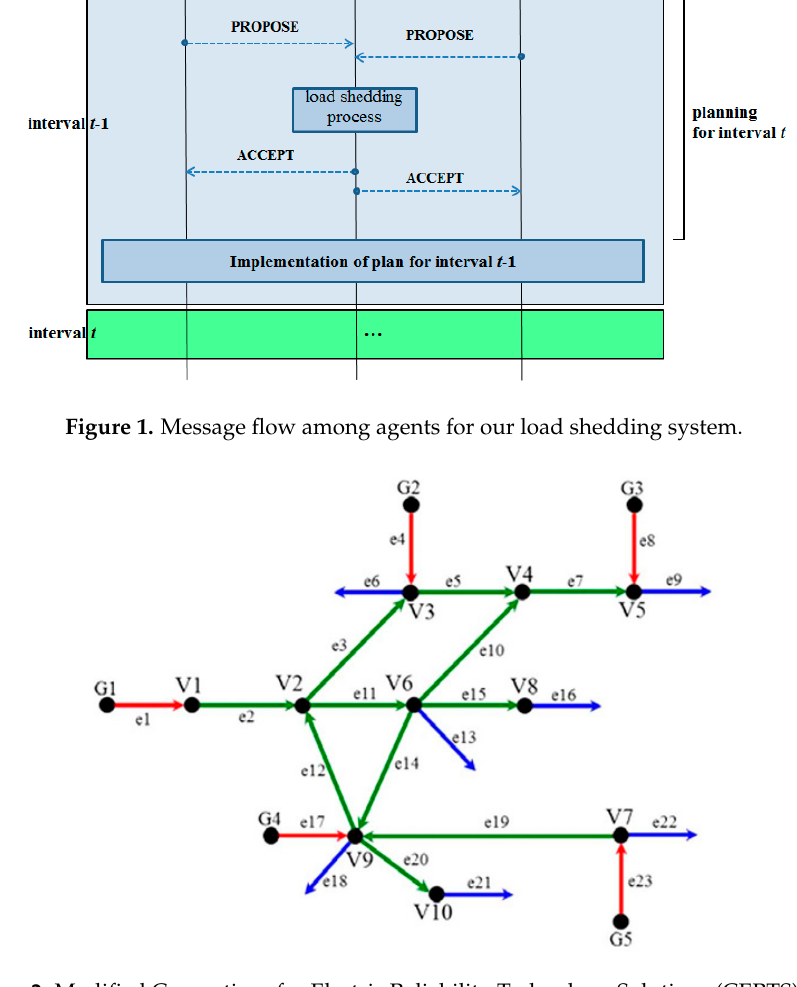
Figure 2. Modified Consortium for Electric Reliability Technology Solutions (CERTS) MG.